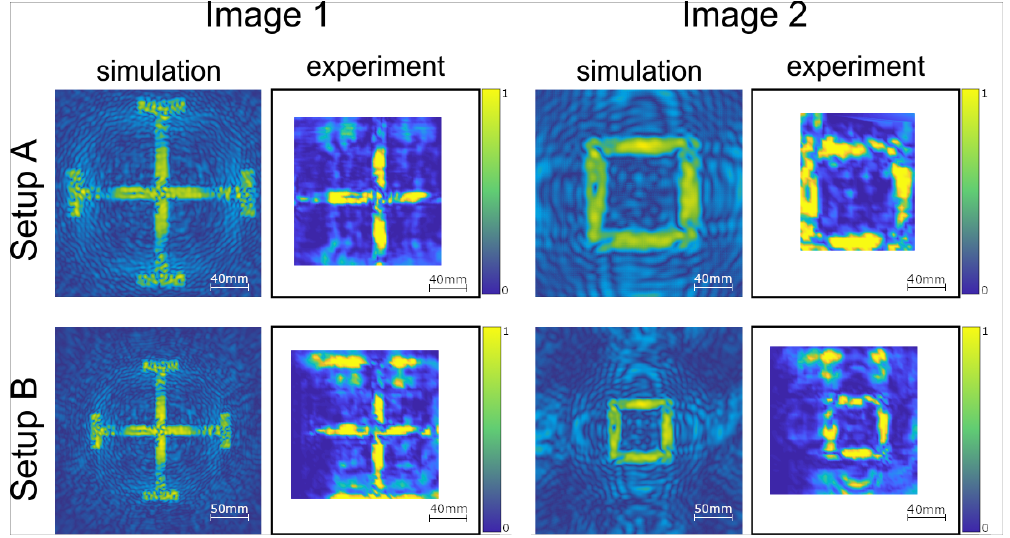
Figure 6. Comparison of the simulation with realistic illumination and experimental results for reconstructing two images from a single hologram. Represented values for the experimental evaluation are